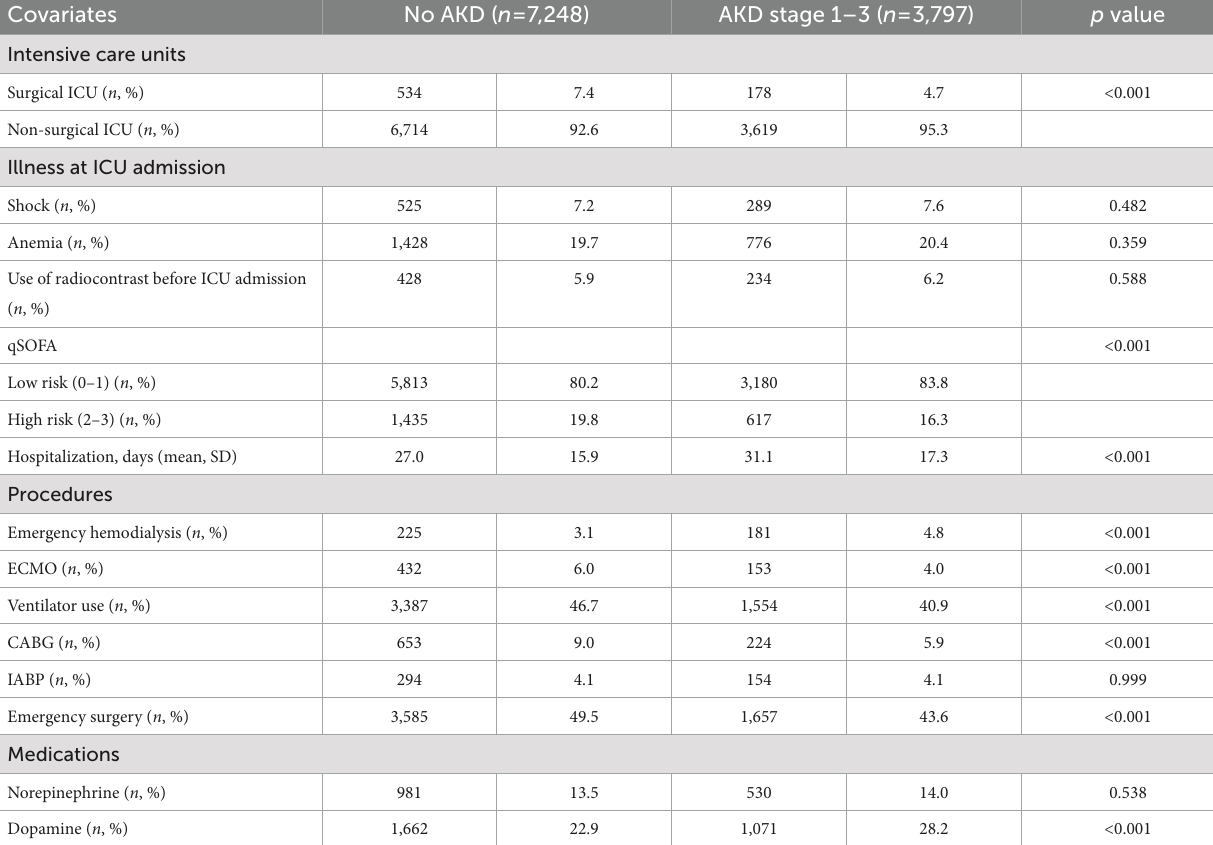
TABLE 2 Association between disease severity upon ICU admission and AKD stages.